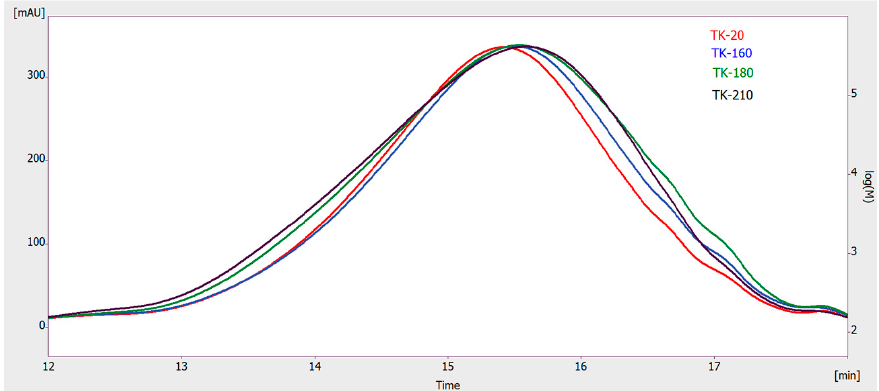
Figure 1. Chromatograms of lignins isolated from untreated and thermally modified teak wood. Table 4. Results of macromolecular characteristics of lignins from teak wood. Data represent mean ± SD.